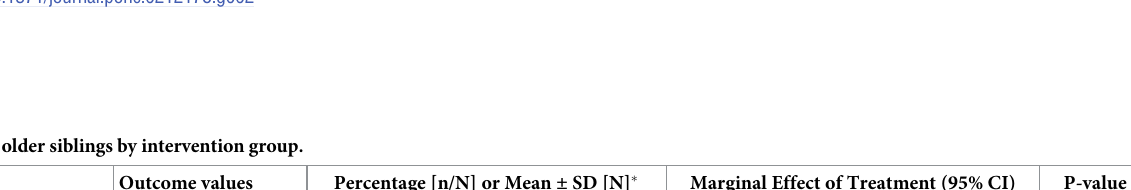
Fig 2. Heterogeneity, by the gender of the household head, in the effect of the intervention on the probability the index child was making age-appropriate progression in school. ��� (p < .01), �� (p < .05), � (p < .1).